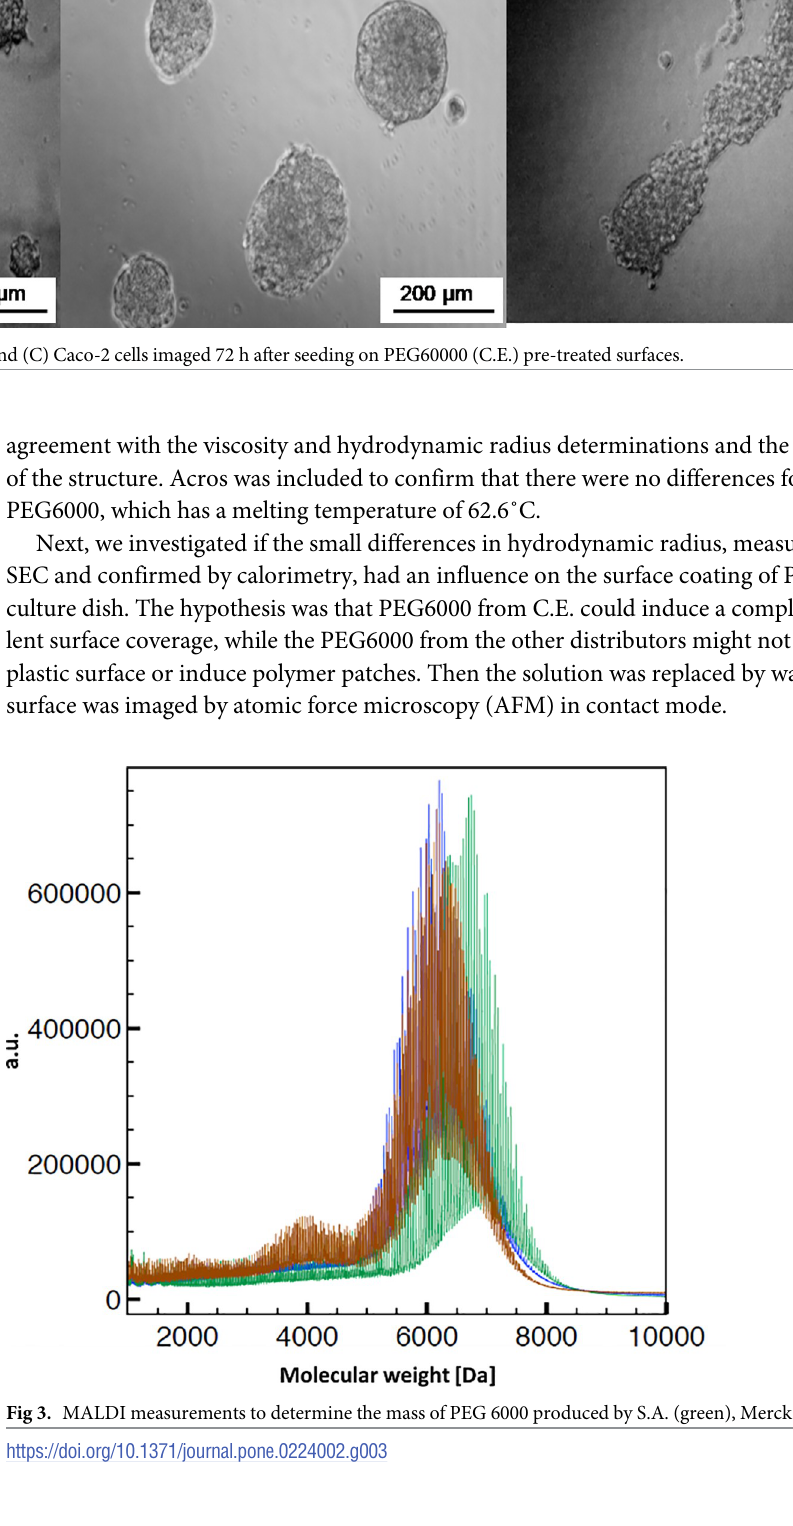
PLOS ONE | https://doi.org/10.1371/journal.pone.0224002 March 19,